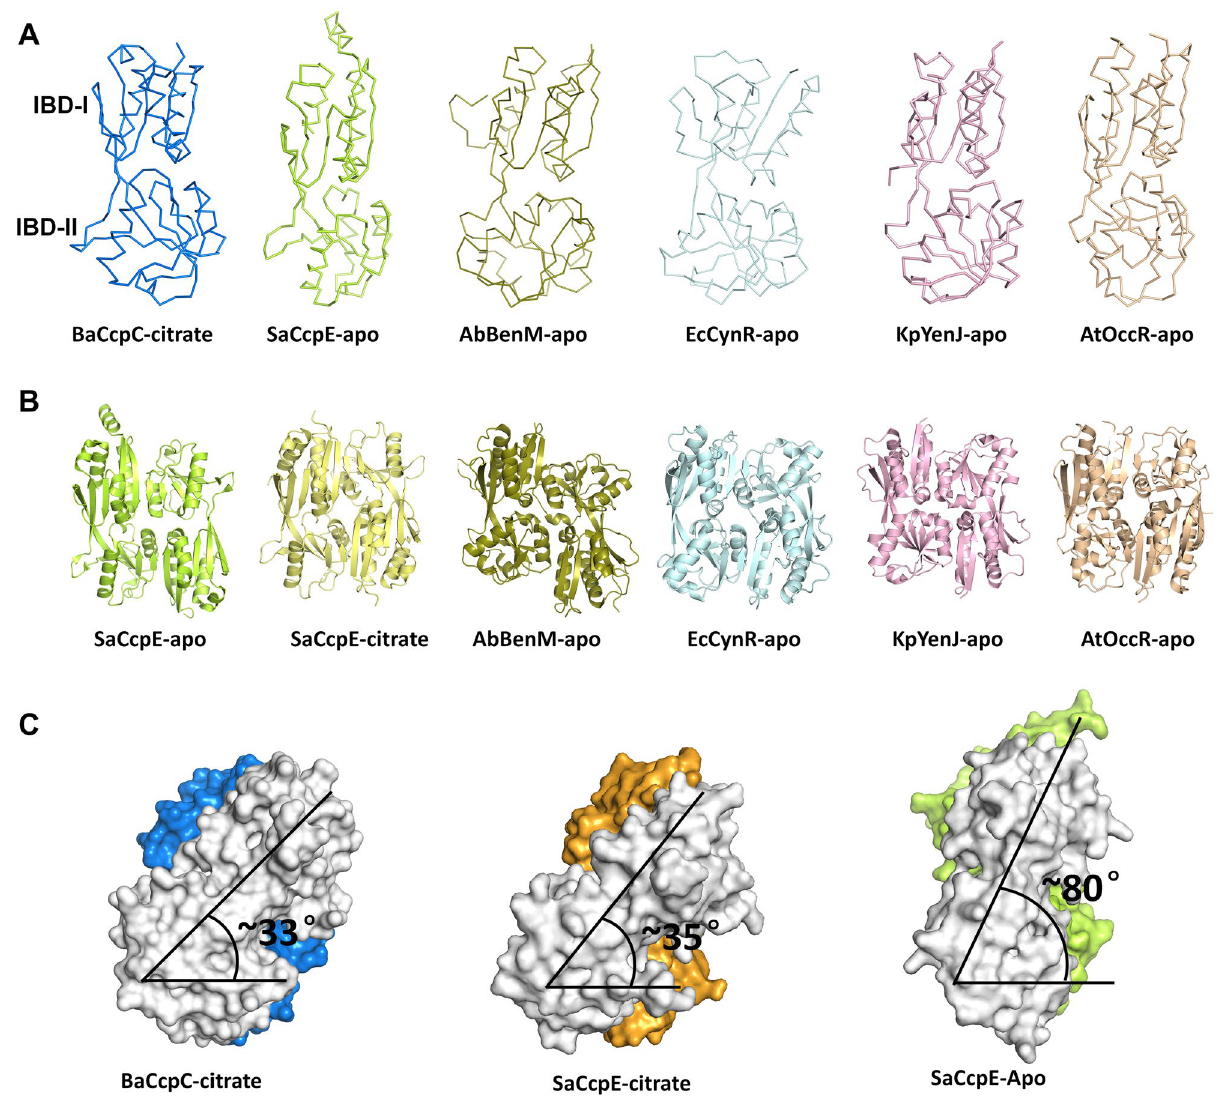
( B ) The tail-to-tail dimers arrangement of BaCcpC, SaCcpE, AbBenM, EcCynR, KpYneJ, and AtOccR. ( C ) Comparison of rotation in BaCcpC-IBD-citrate, SaCcpE-IBD-citrate, and SaCcpE-IBD-apo